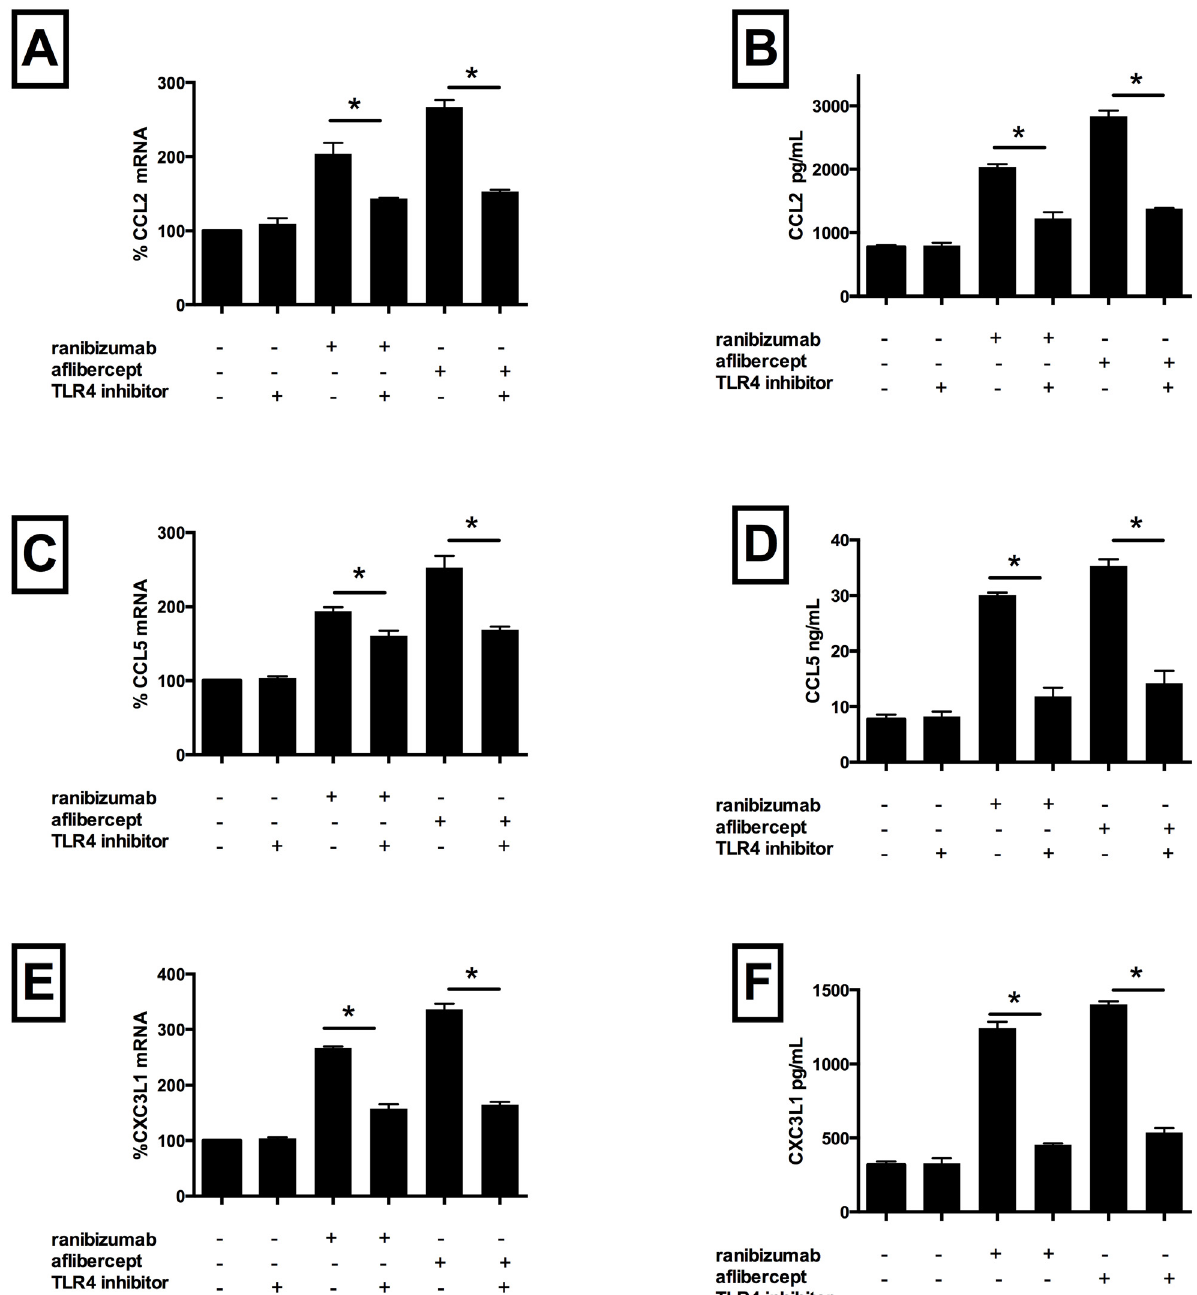
Fig 6. TLR4 receptor inhibition decreased ranibizumab and aflibercept mediated CCL2, CCL5, and CX3CL1 mRNA and protein levels in HCAECs. HCAECs were incubated with ranibizumab (0.1nM) or aflibercept (0.45nM), or PBS (control) and a TLR4 inhibitor for 16 h. Changes in CCL2, CCL5 and CXC3L1 (panels A, C and E) mRNA levels were quantified using real-time PCR. Protein levels (B, D, F) were quantified using ELISAs. Results are expressed as means +/- SEM. * P < 0.05 ranibizumab treated cells vs. ranibizumab-treated TLR4 inhibitor treated cells; ** P < 0.05 aflibercept-treated cells vs. aflibercept treated TLR4 inhibitor treated